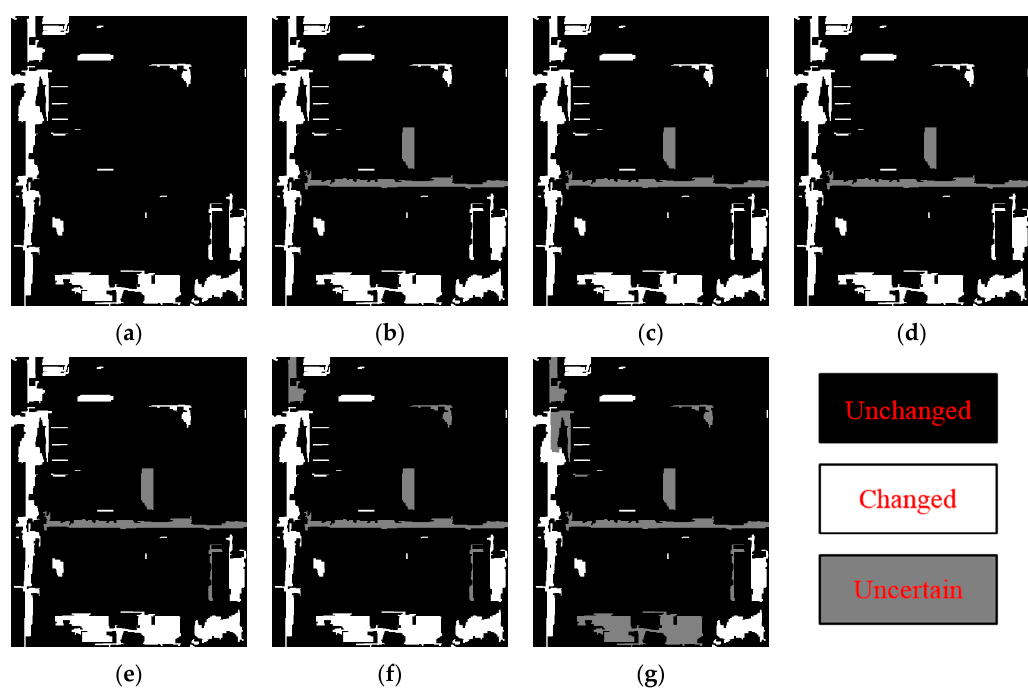
Figure 10. Results of uncertainty analysis for the thresholds of ( a ) 0.6; ( b ) 0.65; ( c ) 0.7; ( d ) 0.75; ( e ) 0.8; ( f ) 0.85 and ( g ) 0.9 using the first segmentation map for Q = 64.